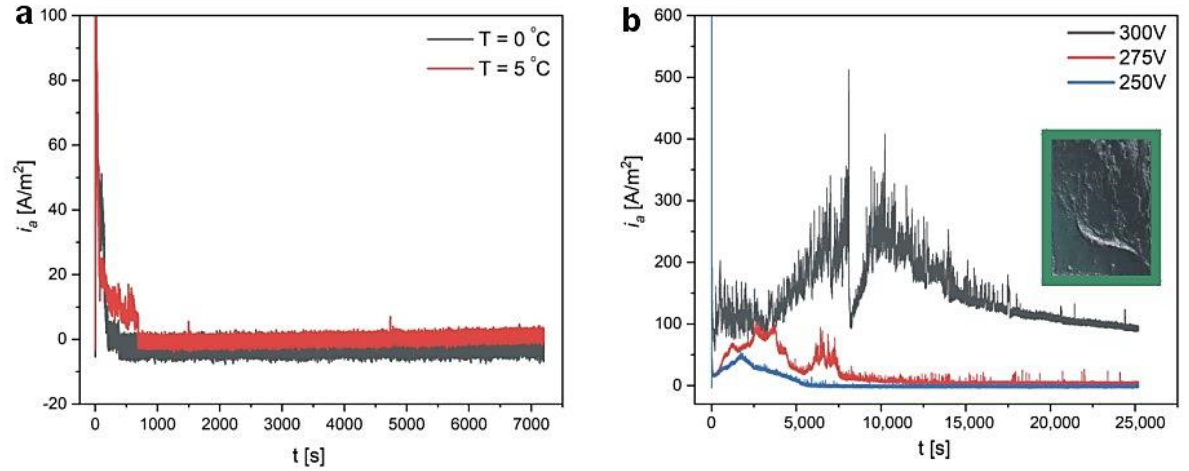
Figure 6. i a ( t ) curves recorded during anodization in 0.5 M citric acid water solution at 300 V and at T = 0 and 5 ◦ C ( a ); i a ( t ) curves recorded during anodization in 1.5 M citric acid water solution at 5 ◦ C and under various anodizing voltages (the insert shows a photograph of the sample anodized in 1.5 M CC at 300 V and 5 ◦ C) ( b ).